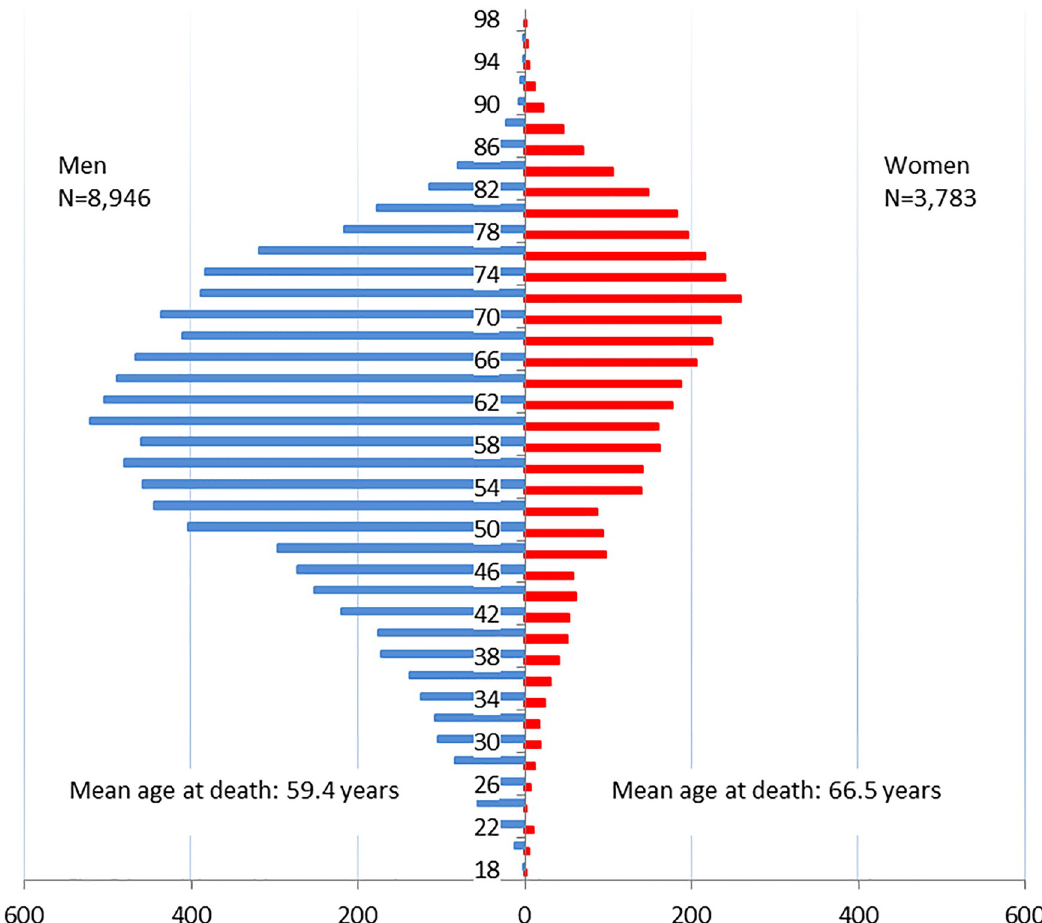
Fig 5. “Age at death” distribution of 12,729 deceased male and female cohort members (1976–2015) (left in blue = men, right in red =